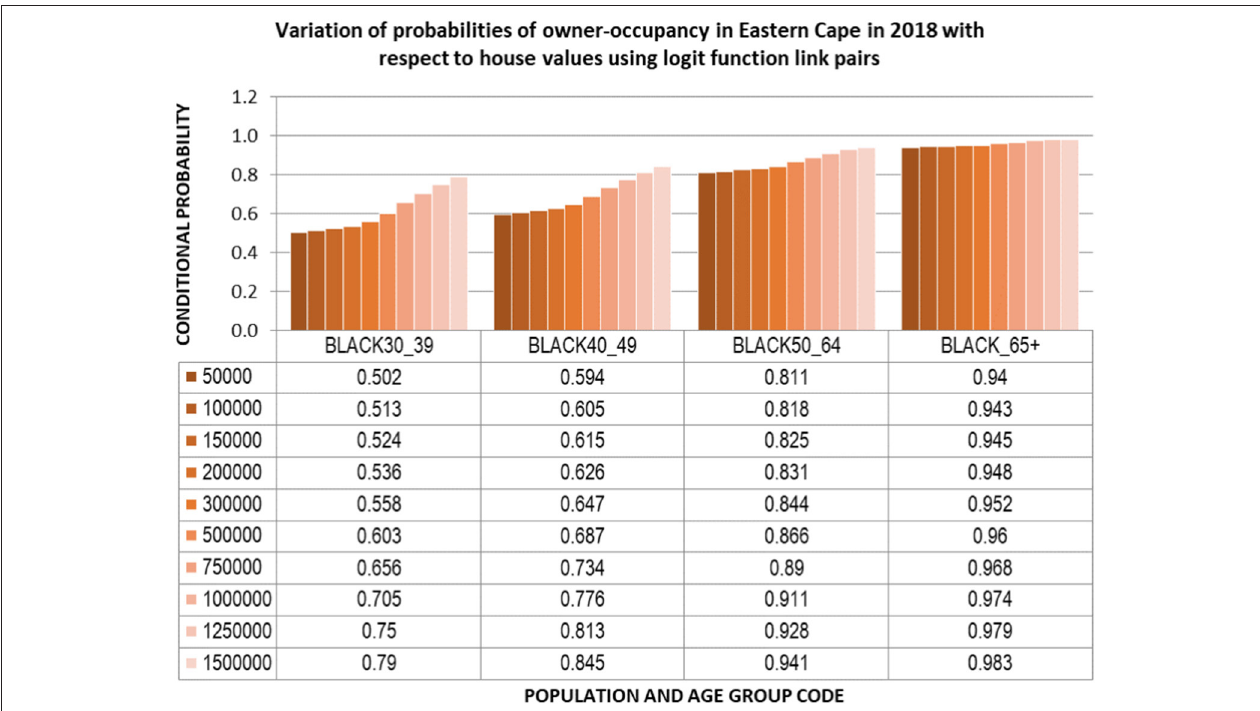
FIGURE 1 | Variation of probabilities of owner-occupancy in Eastern Cape in 2018 (Source: